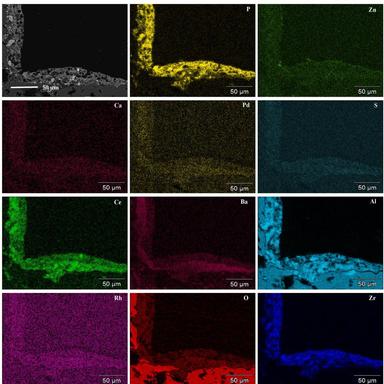
EPMA-EDS map data from the cross-section at the corner of C1.